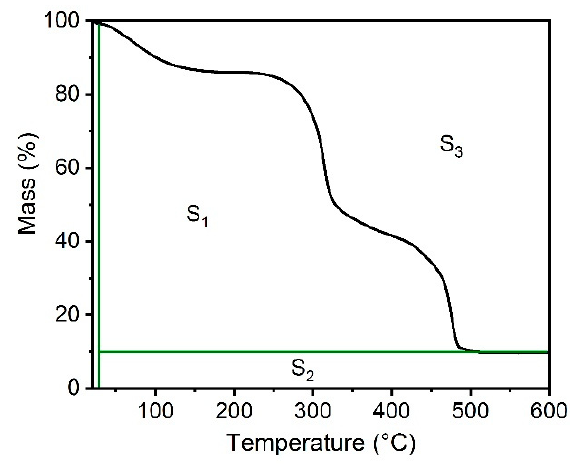
Figure 5. Schematic representation of S 1 , S 2 and S 3 .